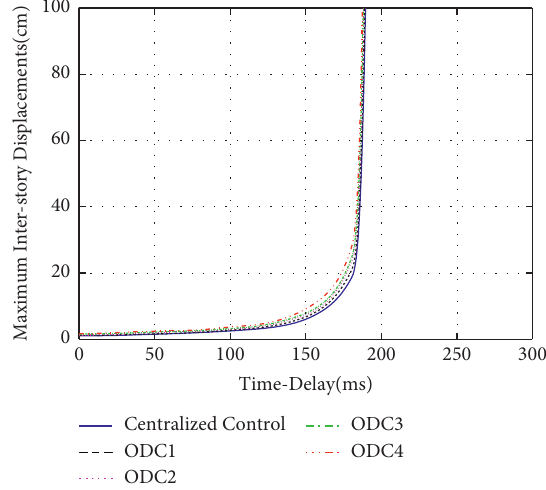
Figure 12: The maximum displacement value of first floor with time